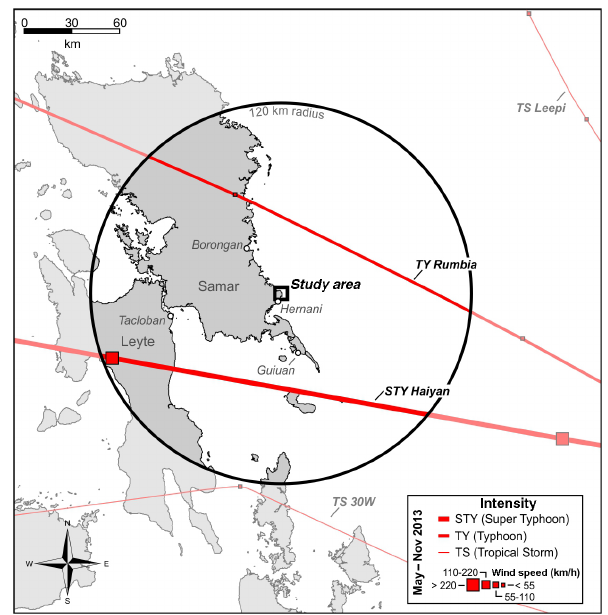
Figure 2. Previous typhoons and tropical storms. Location of study area, track of Supertyphoon Haiyan, and tracks of three further storm systems which occurred within an area of ca. 250km N, S, and E of Eastern Samar between 4 May and 11 November 2013 (JTWC, 2014). Tropical storm 30W (3–6 November 2013) and Typhoon Rumbia (27 June–2 July 2013) only reached moderate wind speeds of ≤ 65kmh − 1 and atmospheric pressures of >995hPa when passing the 120km radius around the study